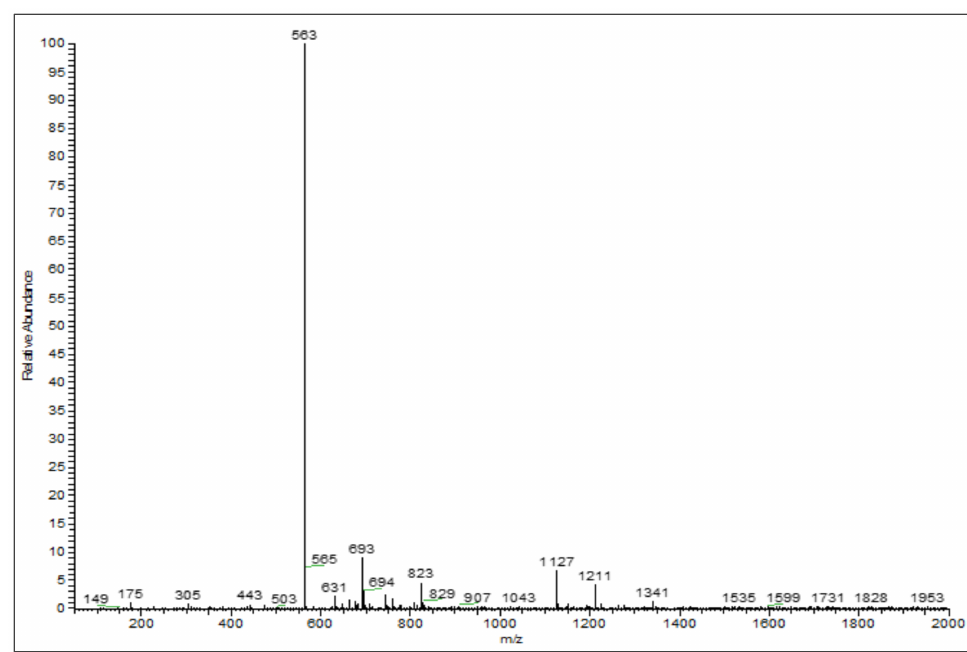
Figure 3. Electro-spray ionization mass spectrum on negative ion of peak 7 (RT 28.71) in ricegrass juice